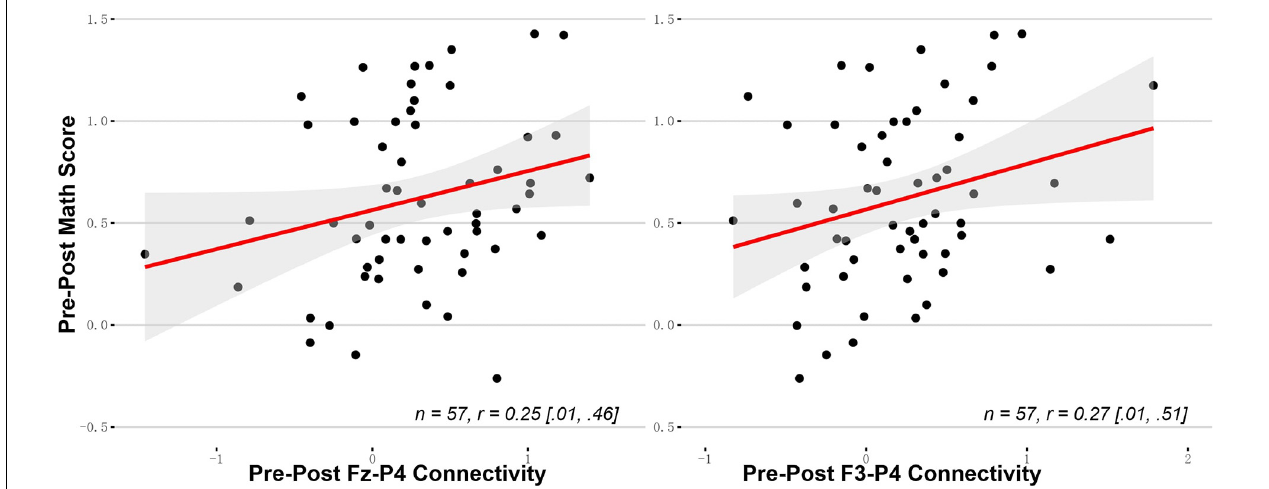
FIGURE 5 | The fronto-parietal rs-EEG connectivity changes correlated with the mathematical improvement. The Bootstrap 95% confidence intervals are reported in the square